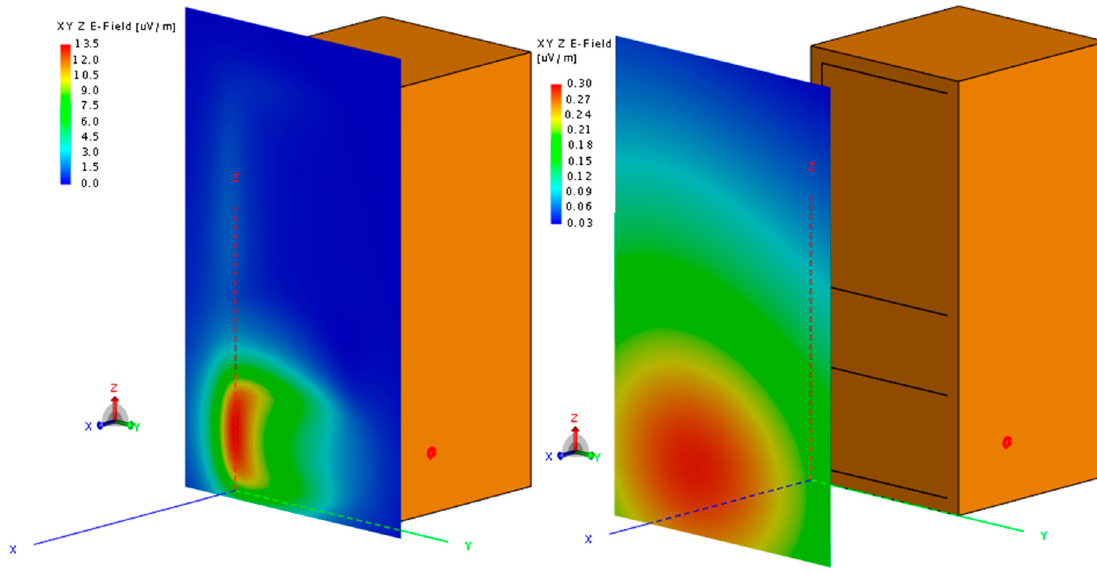
Figure 7. E-field values ( μ V/m) 10 cm ( left ) and 100 cm ( right ) from the cabinet doors, at 2 MHz, noise source modeled as a horizontal wire in the lower cabinet part.